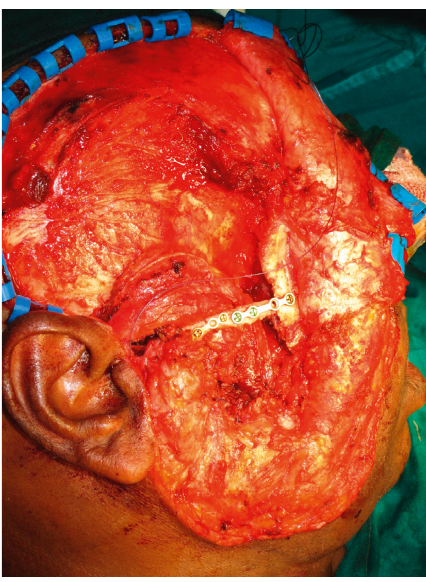
Figure 5: Intraoperative photograph shows the transzygomatic approach and the defect restored with temporalis muscle.